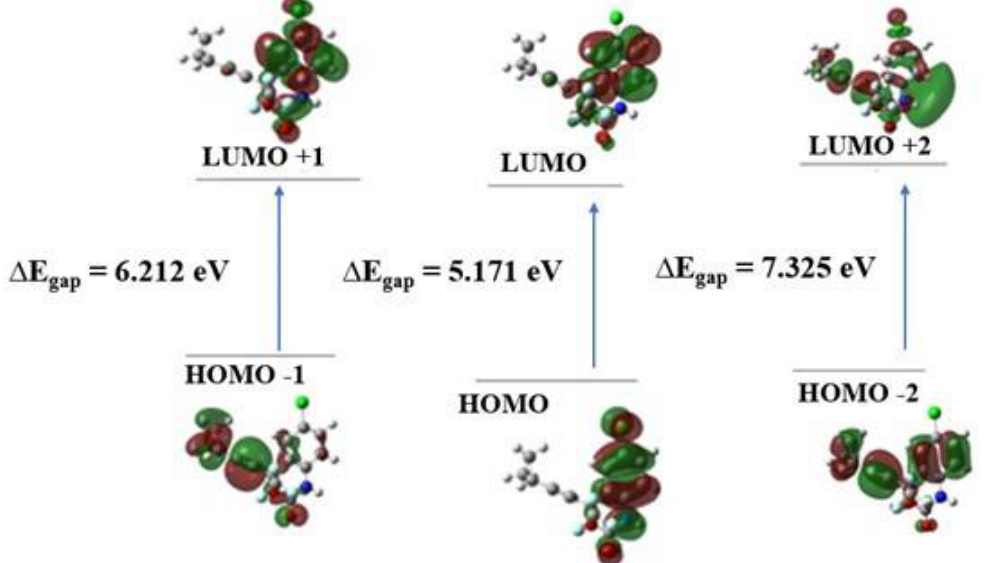
Figure 1. Frontier molecular orbitals on optimized molecular structure of EFV computed at B3LYP/6-311 + G.